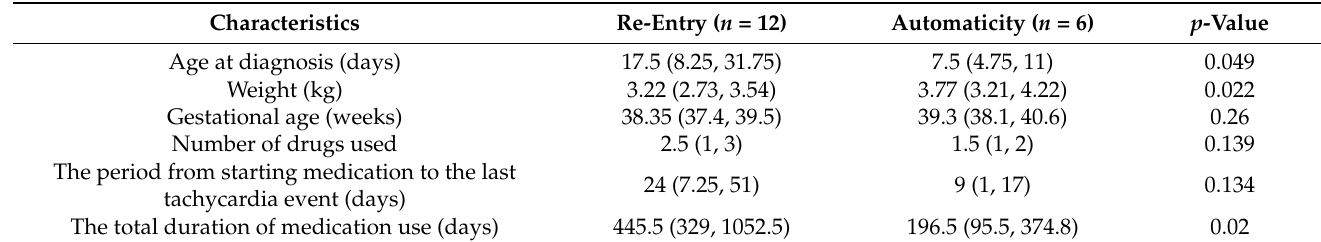
Table 4. Comparison of the two groups according to SVT